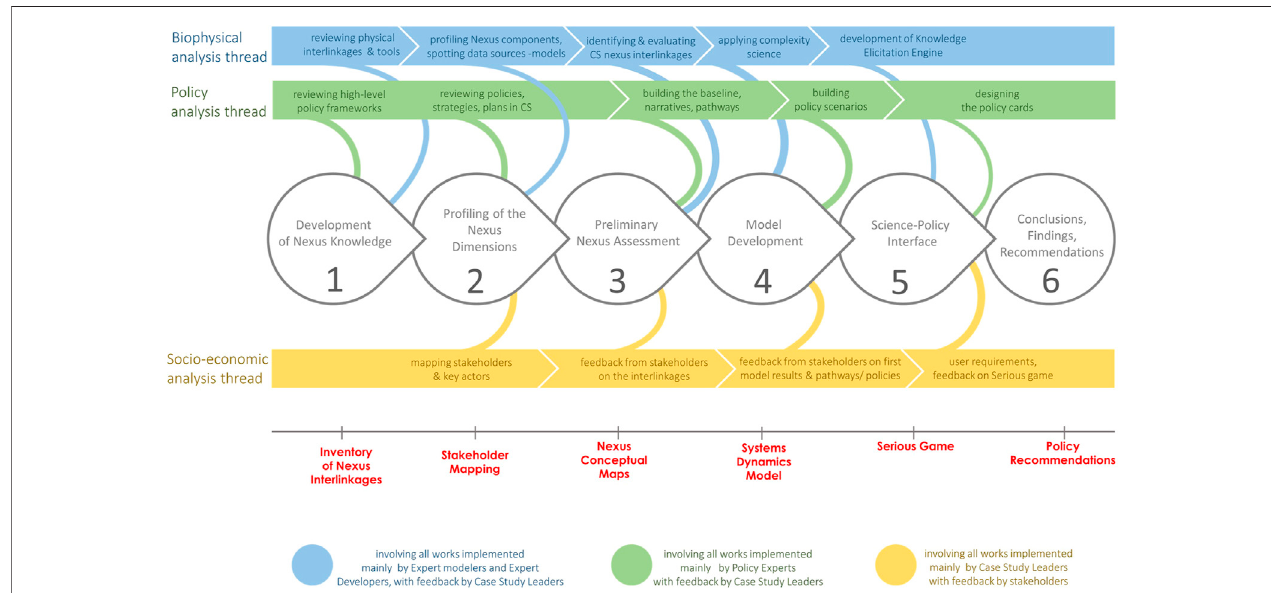
FIGURE2| OverviewofthemainstepsintheSIM4NEXUSapproach,includingthebiophysical,policyandsocio-economicanalysesthreads,andthemainoutputs in a Nexus